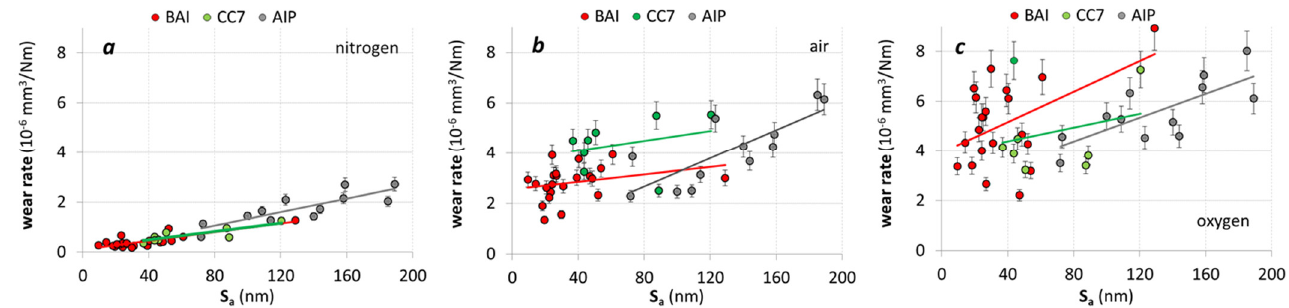
Figure 14. Wear rates of BAI, CC7 and AIP coatings as a function of surface roughness S a . The wear tests were performed in nitrogen ( a ), ambient air ( b ) and oxygen ( c ) atmospheres.